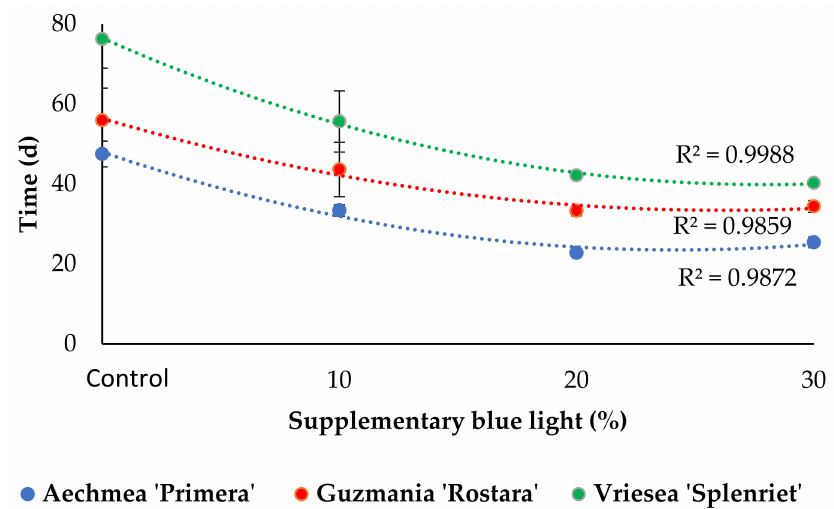
Figure 3. Time to inflorescence emergence following acetylene treatment as a function of the sup- plementary light percentage of blue in the three species under study. Supplementary light included R90B10 [90% red (R) and 10% blue (B)], R80B20 (80% R and 20% B), and R70B30 (70% R and 30% B). Control plants did not receive supplementary light. Data of the two EC treatments were pooled. Eight replicate plants were assessed per treatment. Error bars represent SEM.